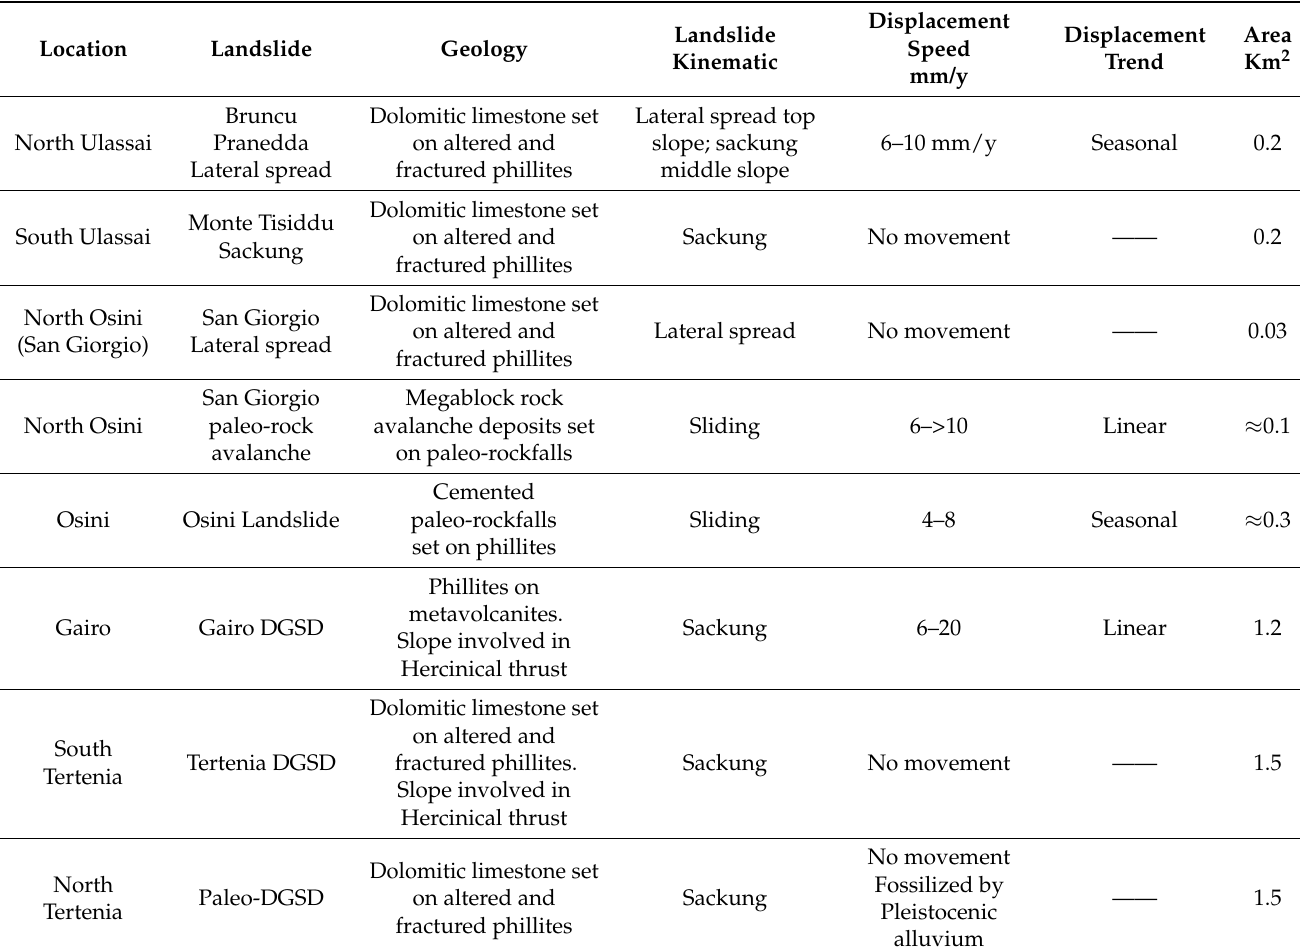
Table 2. Main characteristics of the DGSDs and landslides